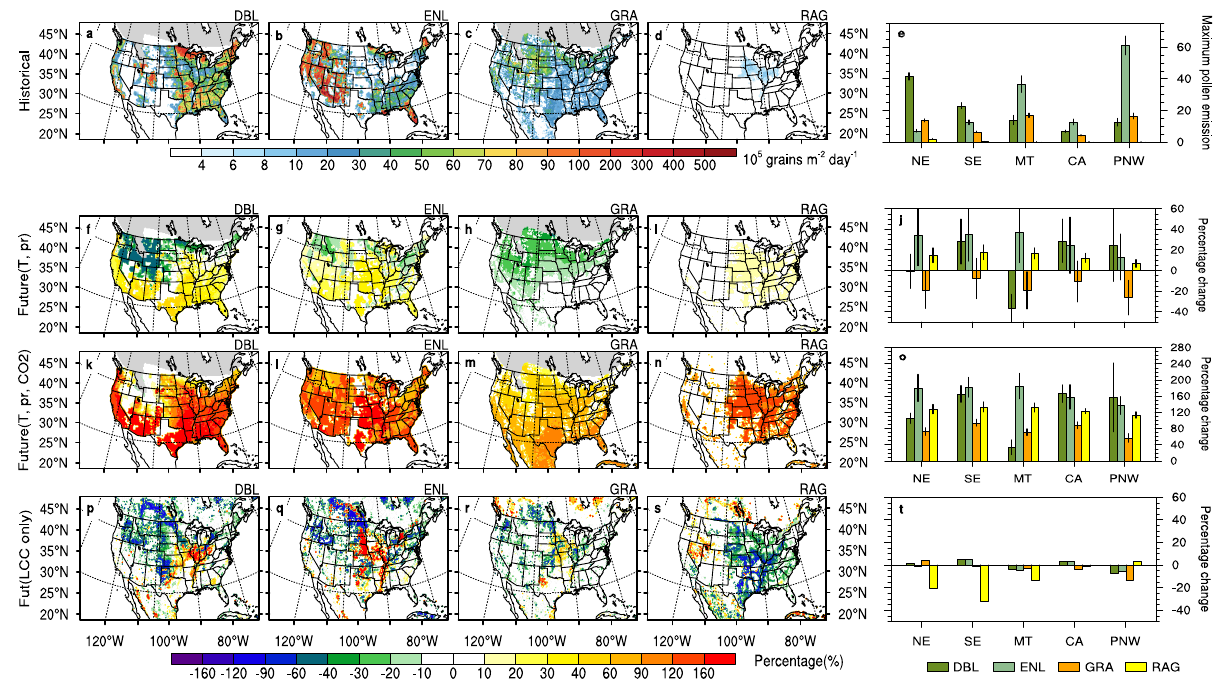
(Fig. 3g) with error bars representing the standard deviation from the average of 15 independent CMIP6 (Coupled Model Intercomparison Project Phase 6) model ensembles ( n = 15) in each region ( e , j , o